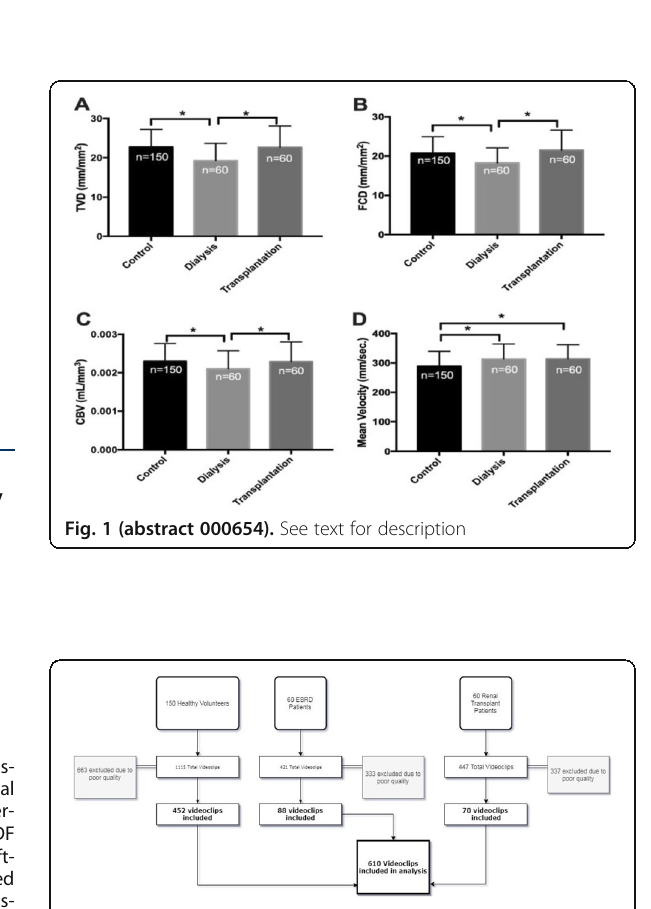
Fig. 2 (abstract 000654). See text for